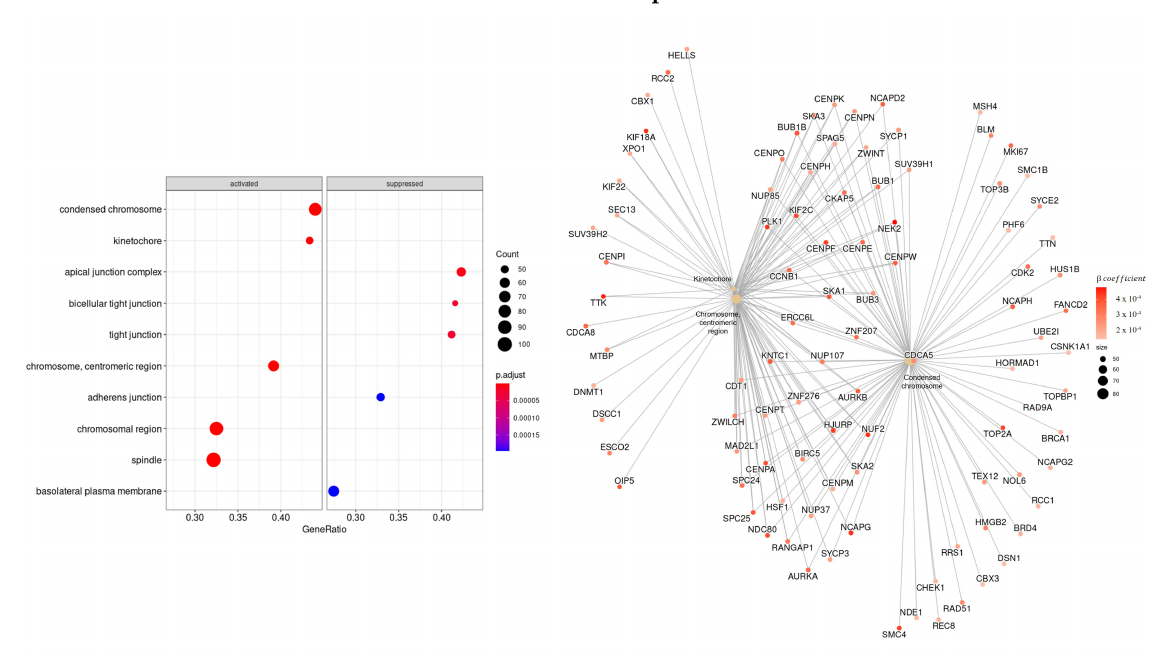
Figure 9. Gene ontology enrichment analysis regarding cellular components terms for a list of genes selected by EN ranked by the β coefficients of the regression. The left panel shows a dot chart with the most significant CC terms and on the right a gene-concept network plot of the three most enriched terms depicts the linkages of genes and biological concepts as a